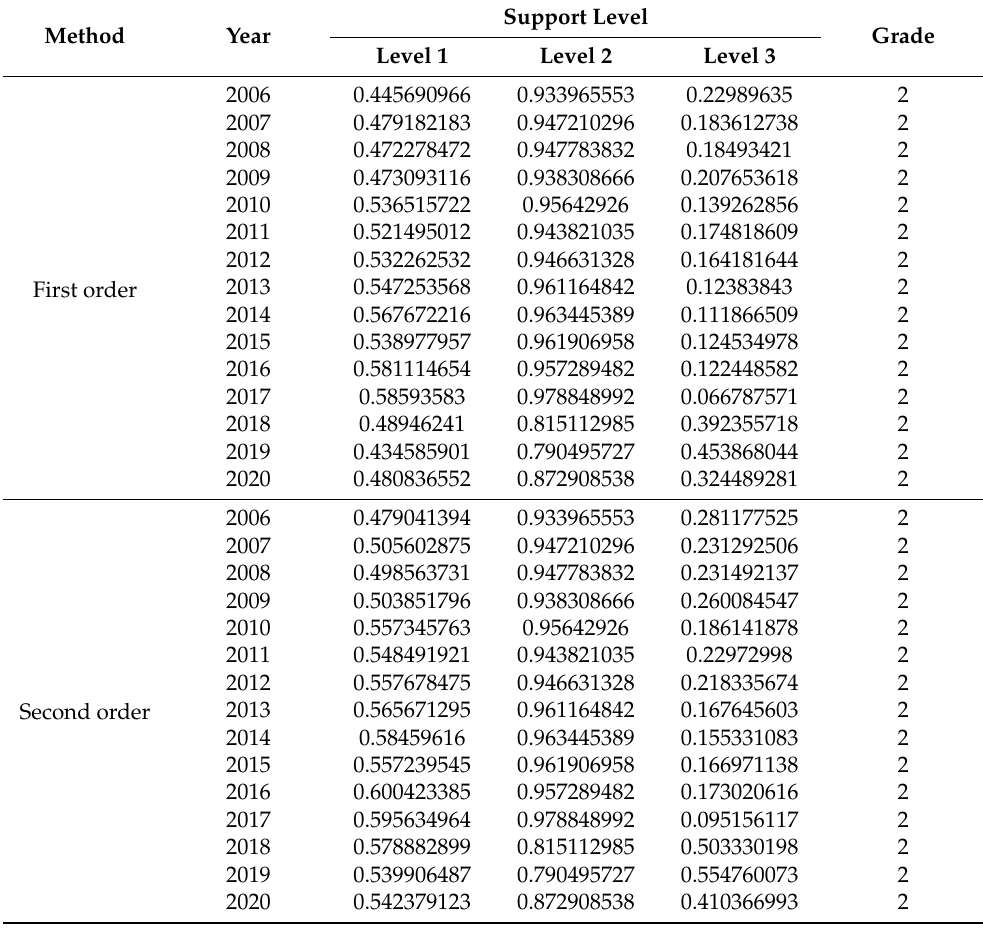
Table 5. Evaluation results of the partial coefficient